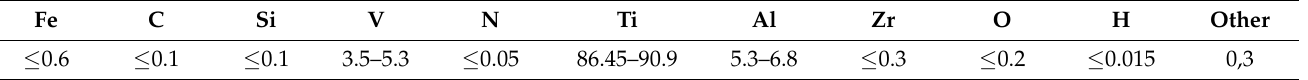
Table 3. Element composition of Ti-6Al-4V alloy